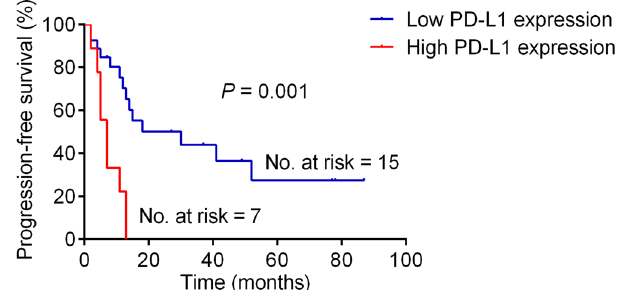
Figure 3. Kaplan–Meier analysis of progression-free survival in the patient cohort stratified by PD-L1 status.